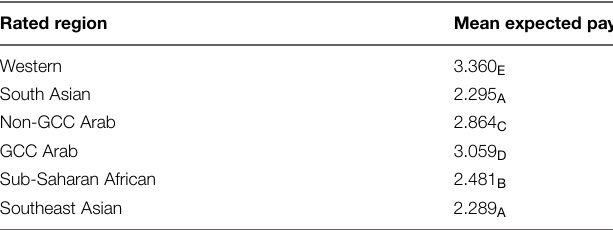
TABLE 4 | Means and homogenous subsets for the main effect of rated region. Rated region